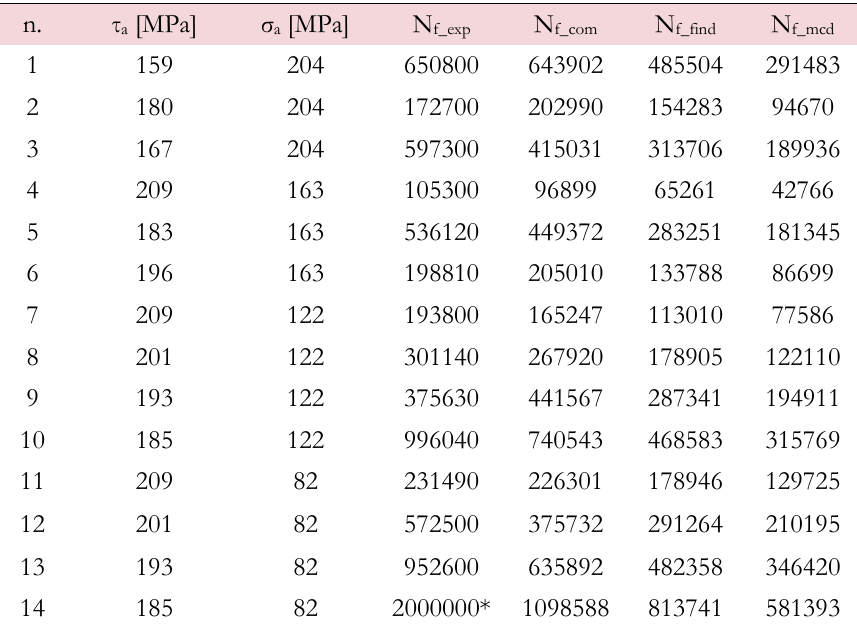
Table 4: Experimental